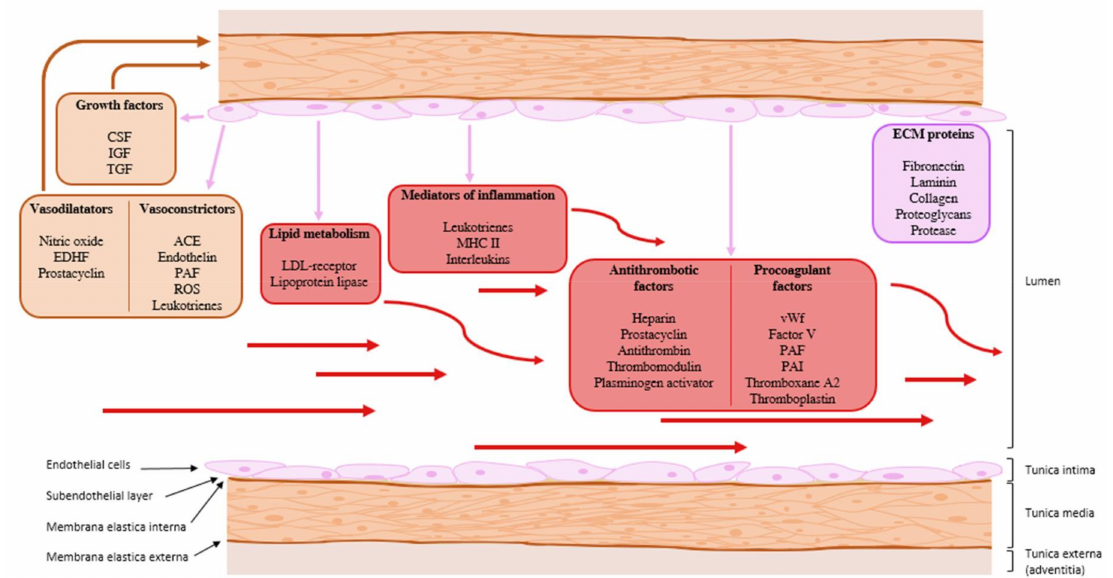
Figure 2. The basic humoral and metabolic functions of the endothelium. ACE: angiotensin converting enzyme; CSF: colony-stimulating factor; ECM: extracellular matrix; EDH: endothelium-derived hyperpolarization; IGF: insulin-like growth factor; LDL receptor: low-density lipoprotein receptor; MHC II: major histocompatibility complex type 2; PAF: platelet-activating factor; PAI: plasminogen activator inhibitor; ROS: reactive oxygen species; TGF: transforming growth factor; vWf: von Willebrand’s factor. Purple arrow: paracrine communication, red arrow: endocrine